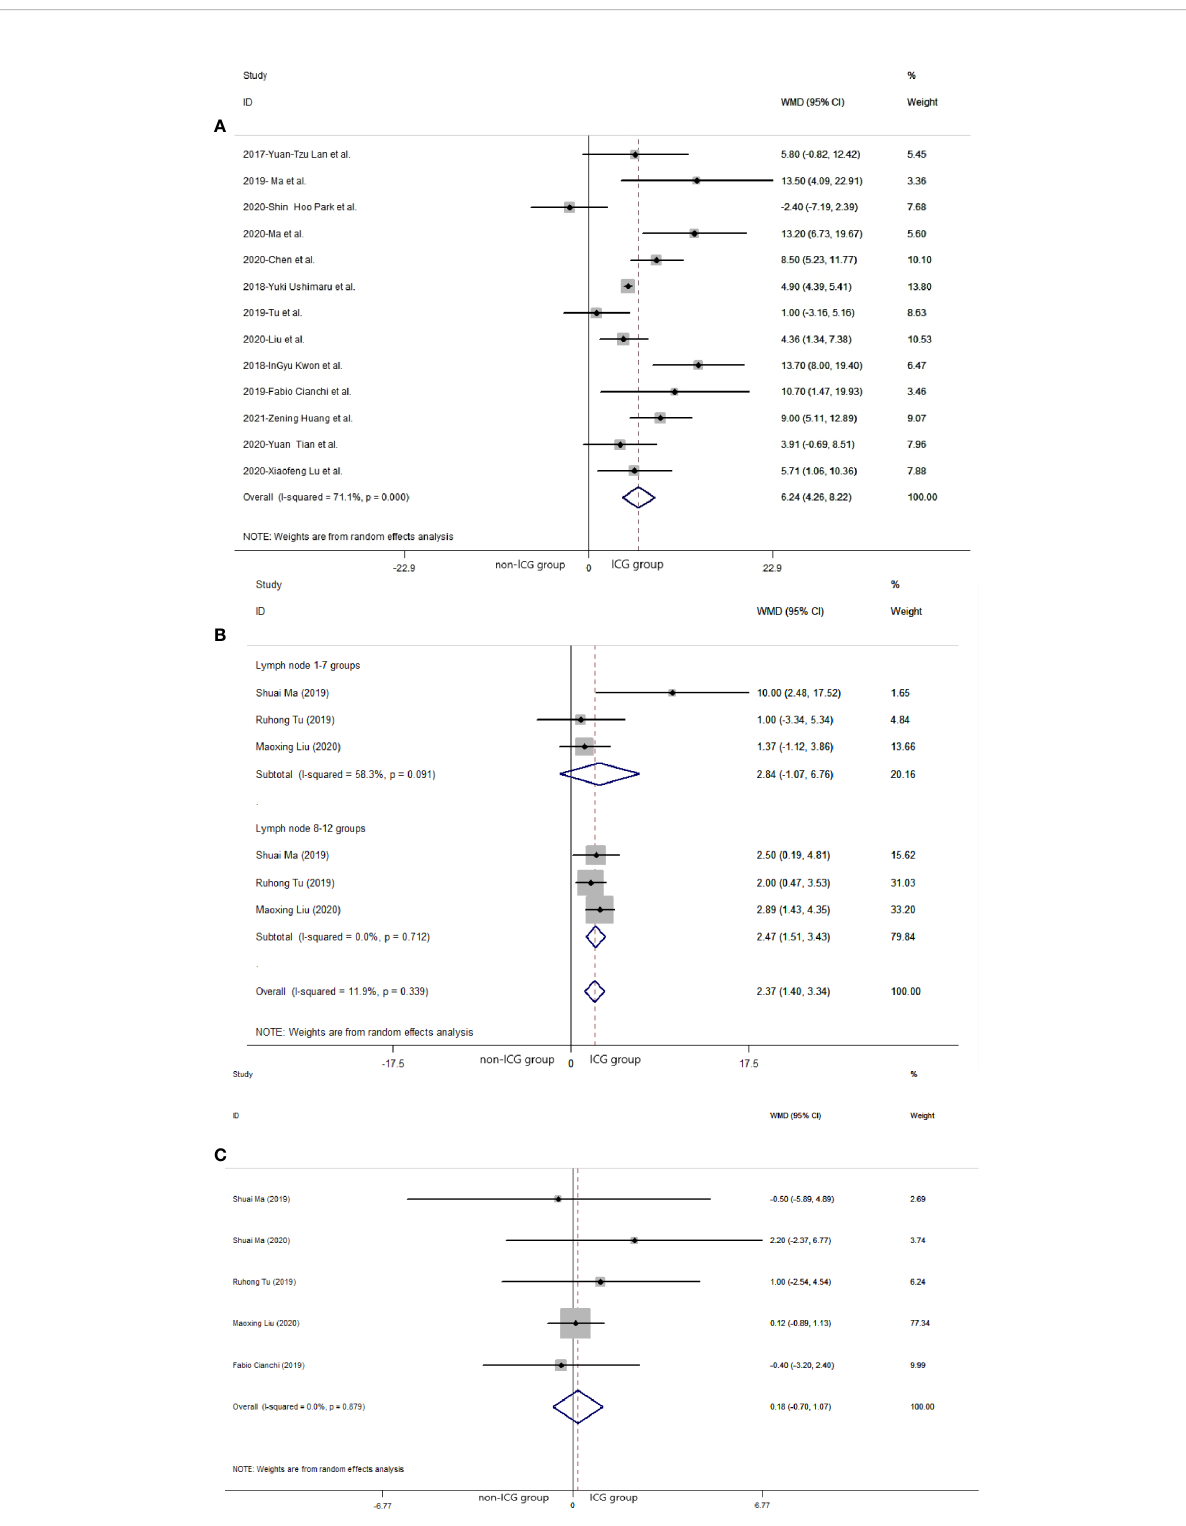
FIGURE 2 Pooled weighted mean difference of ef fi cacy of included studies related to laparoscopic gastrectomy with indocyanine green vs . conventional laparoscopic gastrectomy. (A) Pooled weighted mean difference of ef fi cacy of included studies related to indocyanine green. (B) Pooled weighted mean difference of ef fi cacy of included studies related to indocyanine green in different lymph node groups. (C) Pooled weighted mean difference of ef fi cacy of included studies related to positive (metastatic) lymph